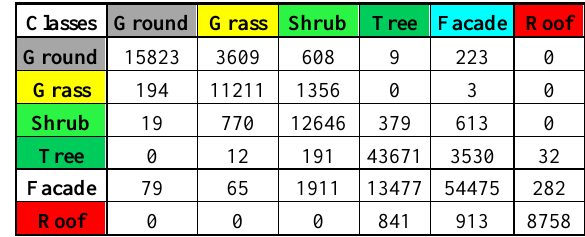
Table 3. Confusion matrix for the classification result on evaluation set (overall accuracy: 83.4%).